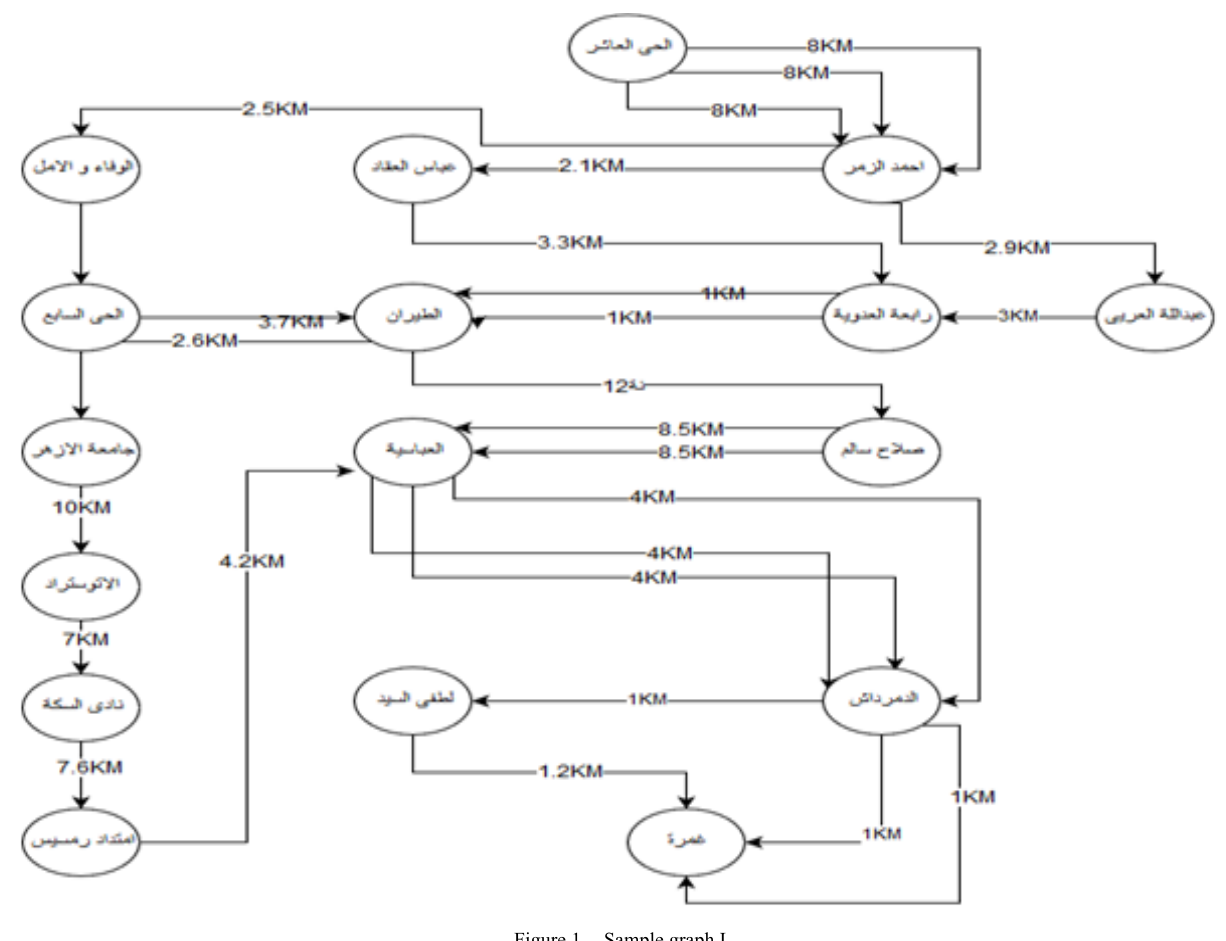
Figure 1. Sample graph